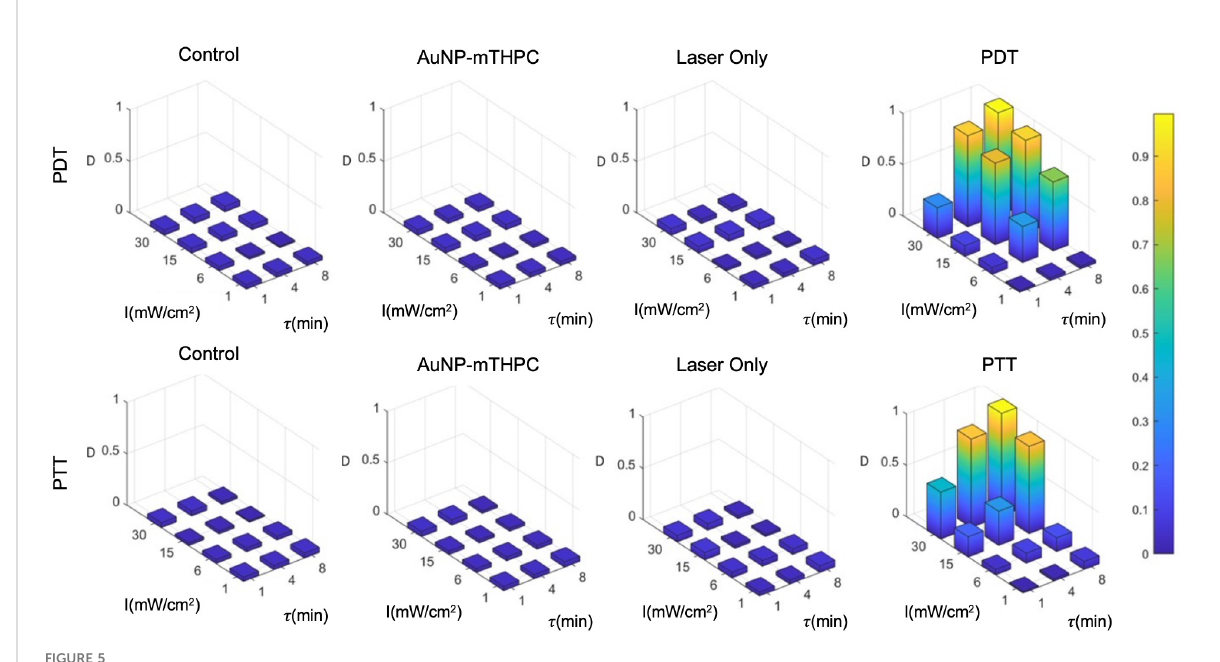
FIGURE 5 PDT and PTT treatment for different feasible treatment durations (min) and intensities (mW/cm 2